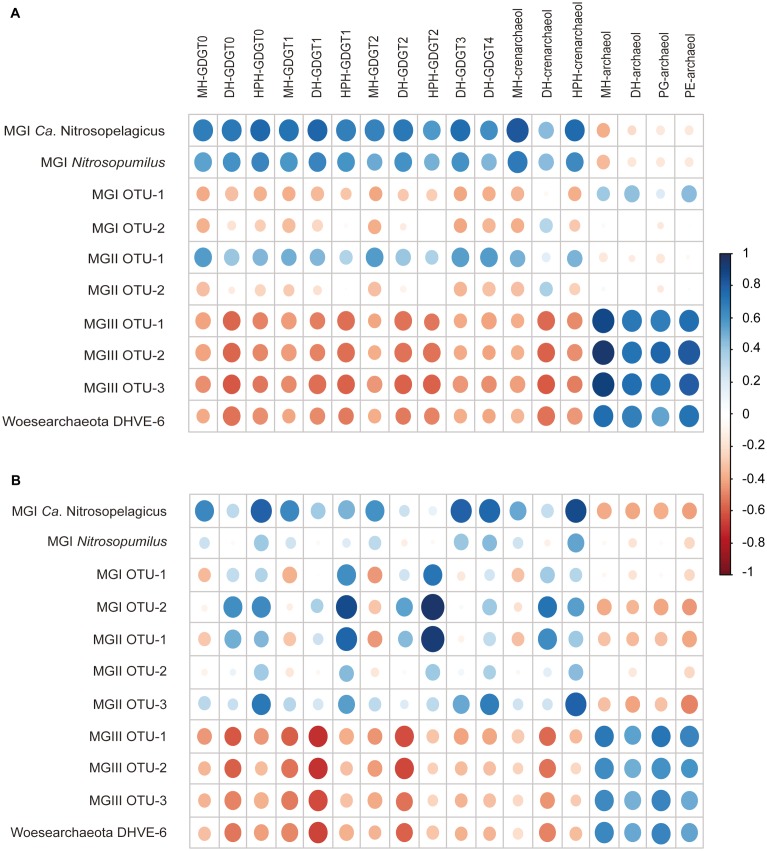
Dot plot of the correlation matrix obtained by applying a Pearson analysis to the total archaeal 16S rRNA gene reads (copies L-1) of the archaeal groups and to the abundances of the archaeal IPLs (response units per Liter; r.u. L-1) detected at the (A) coastal and (B) open ocean stations of the ETSP. Dark blue corresponds to +1 r-values, indicating a strong positive linear correlation between archaeal groups and IPLs; white corresponds to 0 r-values, indicating that no correlation exists; dark red corresponds to –1 r-values, indicating a strong negative linear correlation.